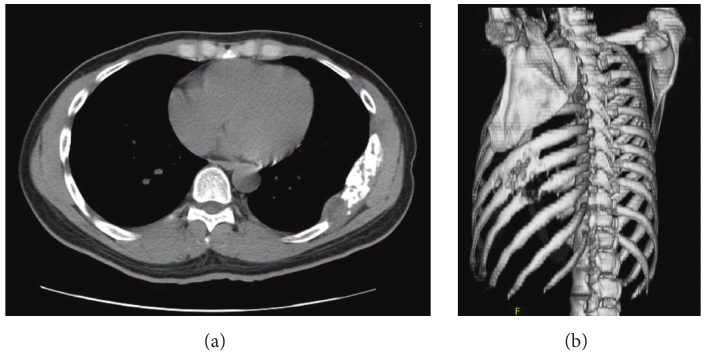
Figure 1: (a) Axial CT chest without contrast and soft tissue views demonstrating the destructive lesion involving the 7-8th ribs. (b) Three- dimensional CT reconstruction of the thoracic cage showing bony destruction of the 7th, 8th, and 9th ribs.